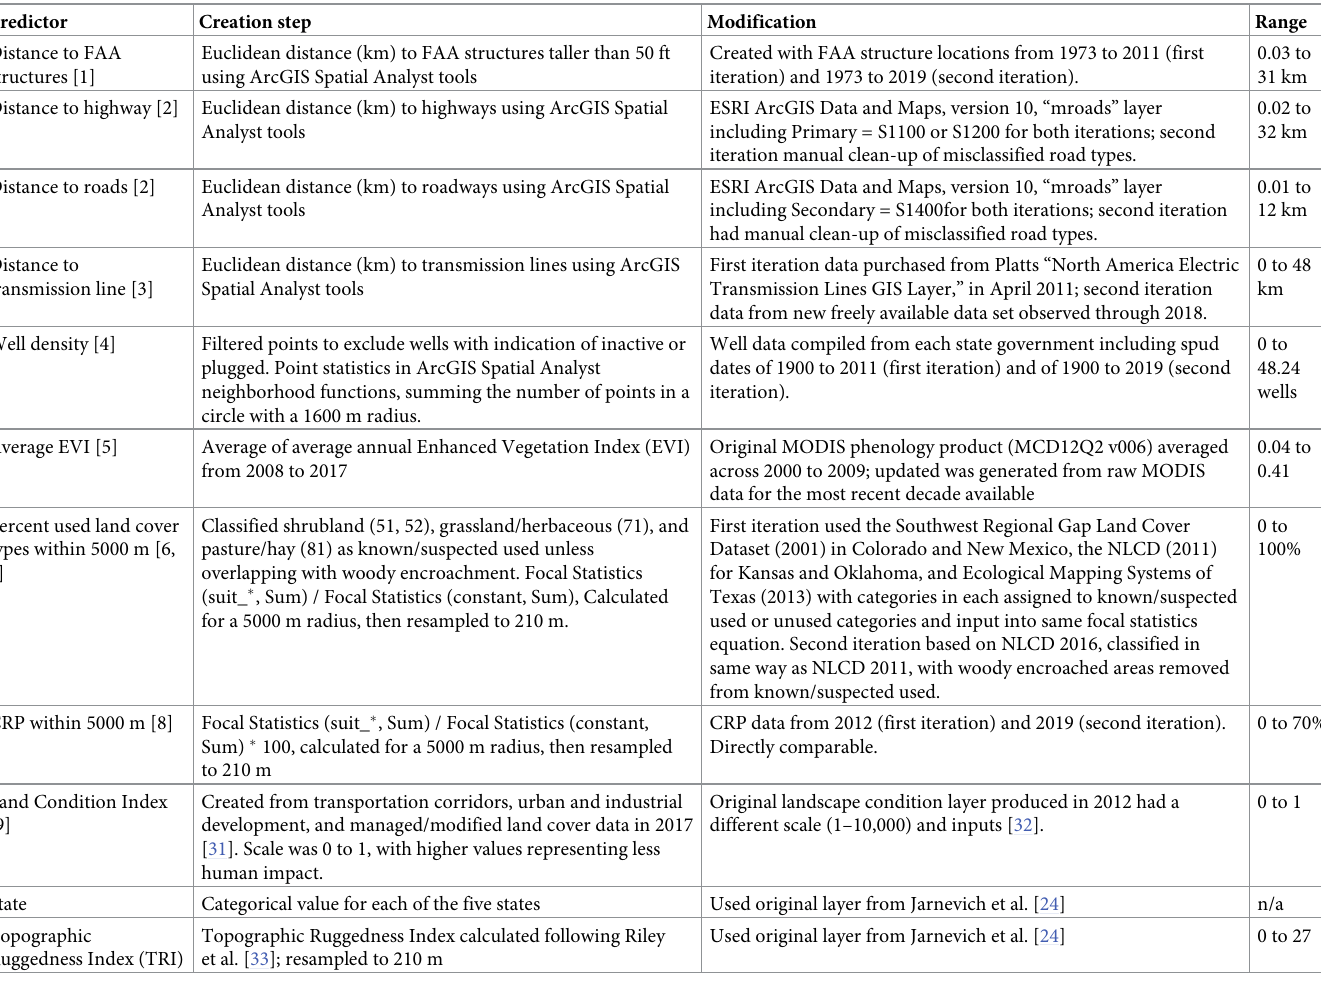
Table 1. Methods and sources used to create predictor variables used to model lesser prairie-chicken lek suitability. Predictor Creation step Modification Range Distance to FAA structures